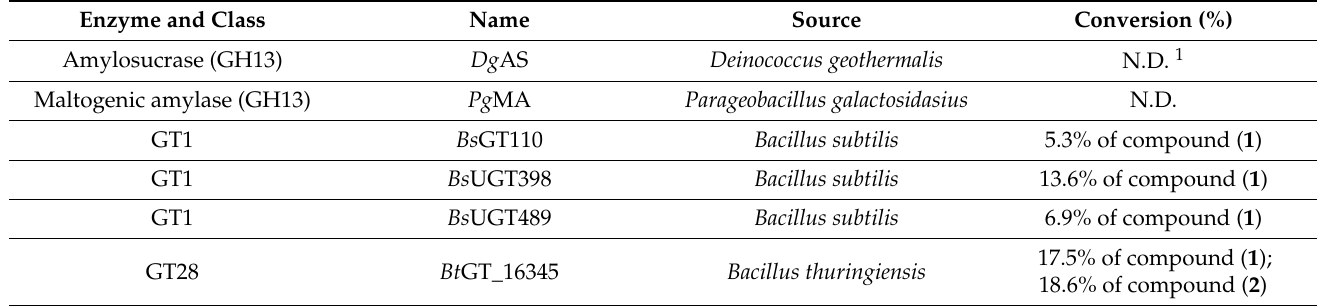
Table 1. Glycosylation activity of the tested GH and GT enzymes toward